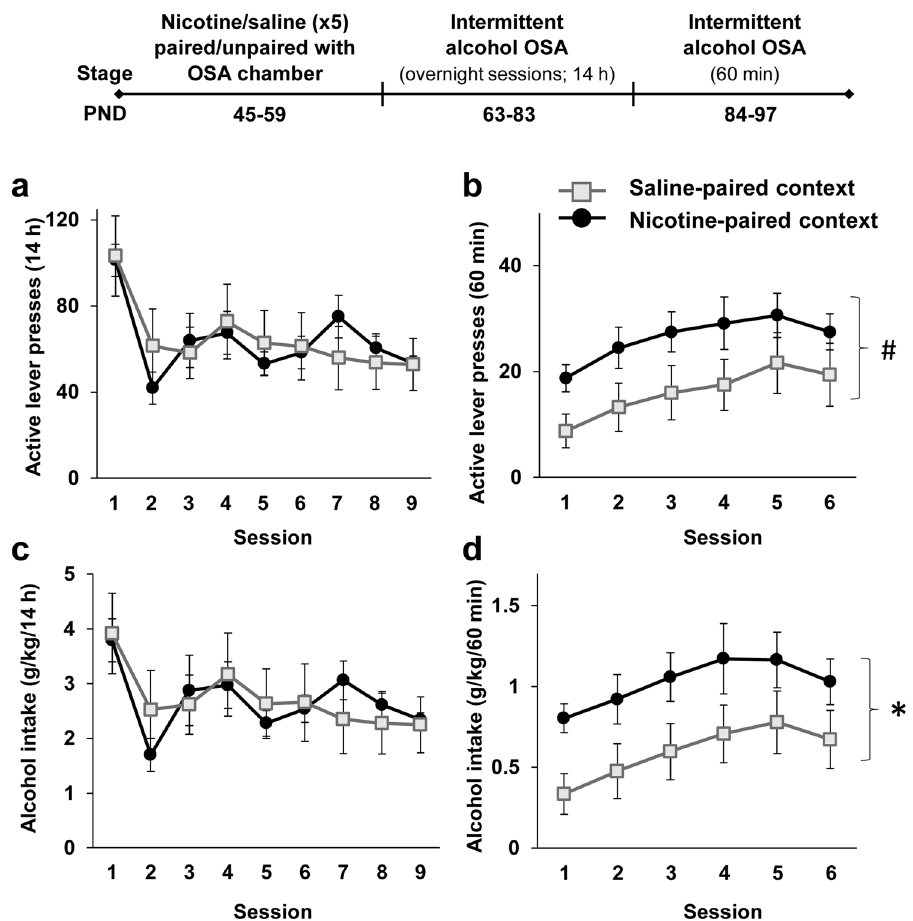
Figure 3. Adolescent nicotine pre-treatment paired with the operant chambers but not with the home cages enhances operant alcohol self-administration in adulthood. Rats were treated with 5 nicotine and saline injections on PND 45–59. Nicotine treatment was either paired with the operant self-administration (OSA) chambers (Nicotine-paired context group), or unpaired with the OSA chamber by placing the rats in the home cage following nicotine treatment, while pairing the chamber with saline (Saline-paired context group). On PND 63 rats began intermittent overnight operant alcohol self-administration training three days a week (fixed ratio 1; FR1) for 3 weeks. On PND 84, rats began intermittent operant training (FR1) of 60 min three days a week for 2 weeks. ( a–d ) Means ± SEM of the number of active lever presses ( a and b ) or alcohol intake normalized to body weight ( c and d ) during the overnight ( a and c ) or 60-min ( b and d ) sessions. Mixed-model ANOVA; Overnight sessions: A main effect of Session for active-lever presses [F(8,112) = 9.47, p < 0.0001] and for alcohol intake [F(8,112) = 5.70, p < 0.0001], but no significant main effect of Context-pairing and no significant Context-pairing X Session interaction (p > 0.1); 60-min sessions: A main effect of Context-pairing for alcohol intake [F(1,14) = 4.97, p < 0.05] and marginally significant for active lever presses [F(1,14) = 3.81, p = 0.071], a main effect of Session for active lever presses [F(5,70) = 5.15, p < 0.001] and for alcohol intake [F(5,70) = 4.40, p < 0.005], but no significant Context-pairing X Session interaction (p > 0.1). n = 8 per group; * p < 0.05; # p =